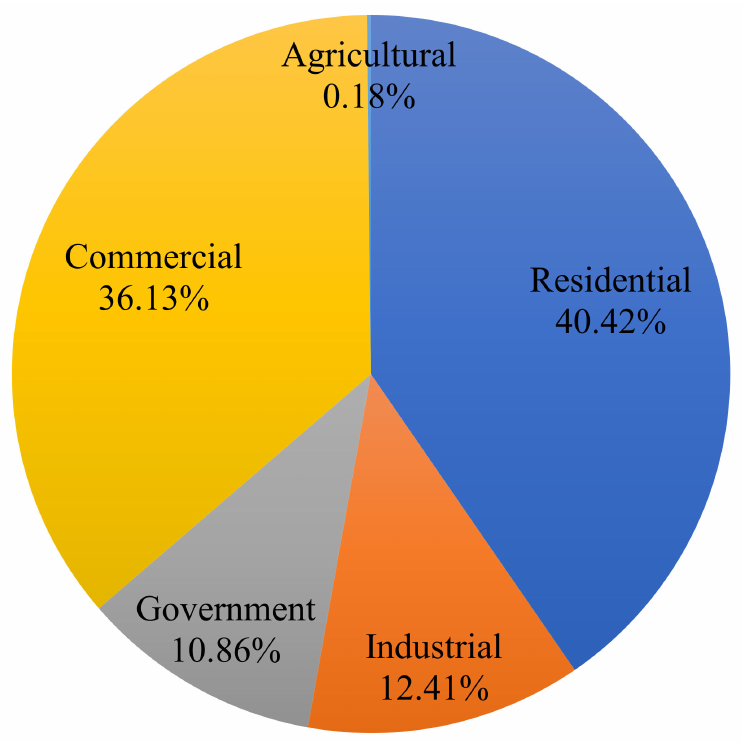
Figure 5. Electric power demand per sector in Sharjah City for 5 consecutive years between 2016 and